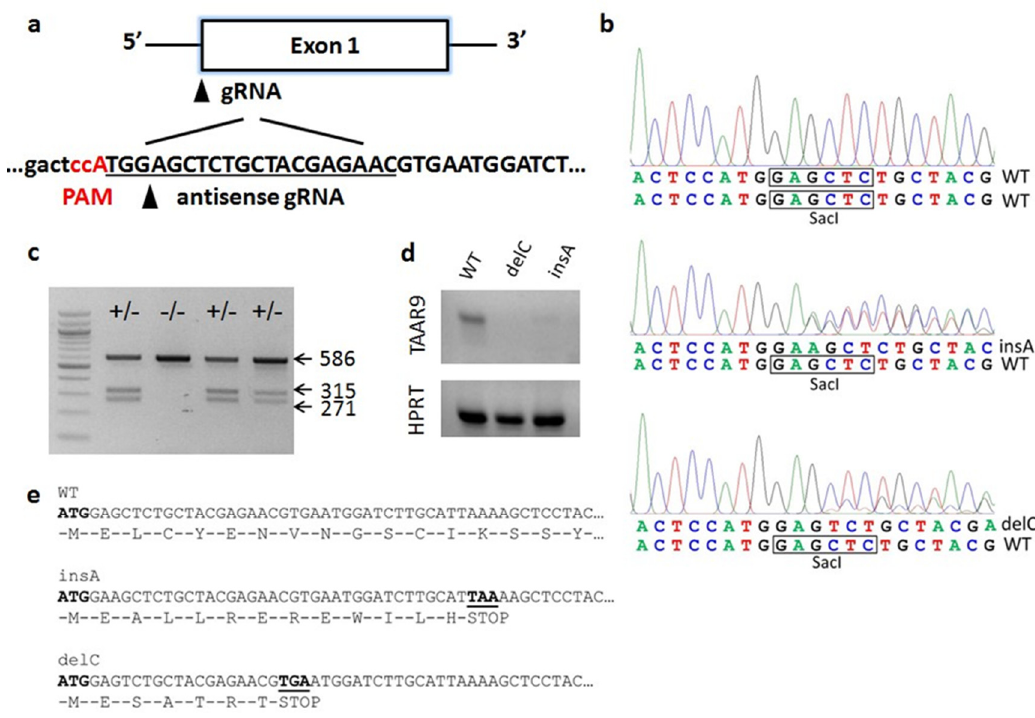
Figure 1. Generation of TAAR9-KO rats. ( a ) Diagram of the TAAR9 exon 1 sgRNA. The sgRNA sequence is underlined. Protospacer adjacent motif (PAM) sequence is indicated in red; the arrow indicates the Cas9 cutting site; the sequence in capital letters indicates the TAAR9 open reading frame. ( b ) Chromatograms of the TAAR9 genomic sequence from WT (upper panel), heterozygous insA (middle panel), and heterozygous delC (lower panel) animals. The black frame indicates the SacI restriction site on the WT allele. The SacI site was destroyed by both A insertion and C deletion. ( c ) Genotyping of TAAR9-KO rats generated by CRISPR-Cas9 technology by SacI digestion of PCR fragments. Undigested 586 bp band corresponds to the KO allele; the appearance of two bands, 315 bp and 271 bp, corresponds to a WT allele. The presence of all three bands corresponds to a heterozygous animal. ( d ) Reverse transcription-polymerase chain reaction (RT-PCR) with TAAR9- and HPRT (housekeeping gene)-specific primers using RNA isolated from the main olfactory epithelium (MOE) of WT, KO delC , and KO insA rats. These gel images are cropped, and full-length images are presented in Supplementary Figure S1. ( e ). N-terminal TAAR9 protein sequences of the WT, KO insA , and KO delC animals. Both A insertion and C deletion result in a premature stop codon and synthesis of short, non-functional peptides.